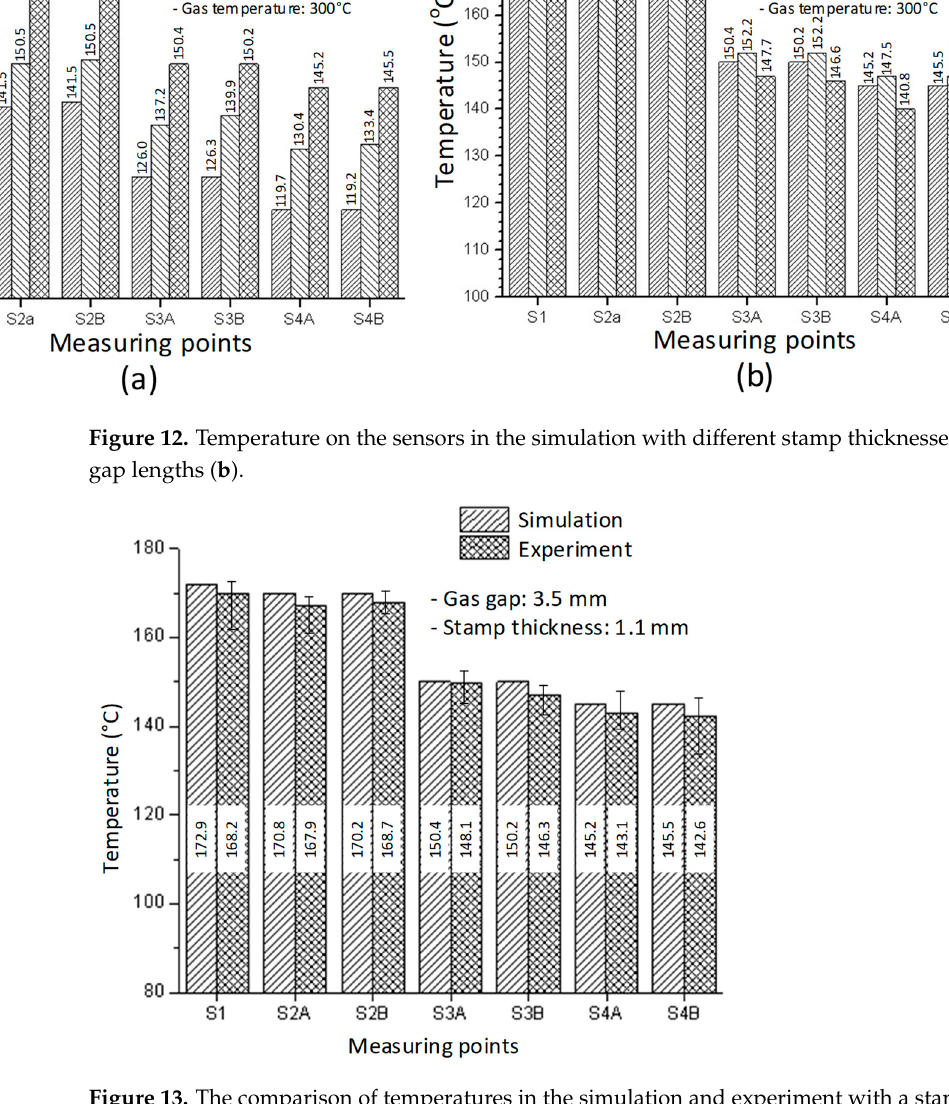
Figure 12. Temperature on the sensors in the simulation with different stamp thicknesses ( a ) and gas gap lengths ( b ).